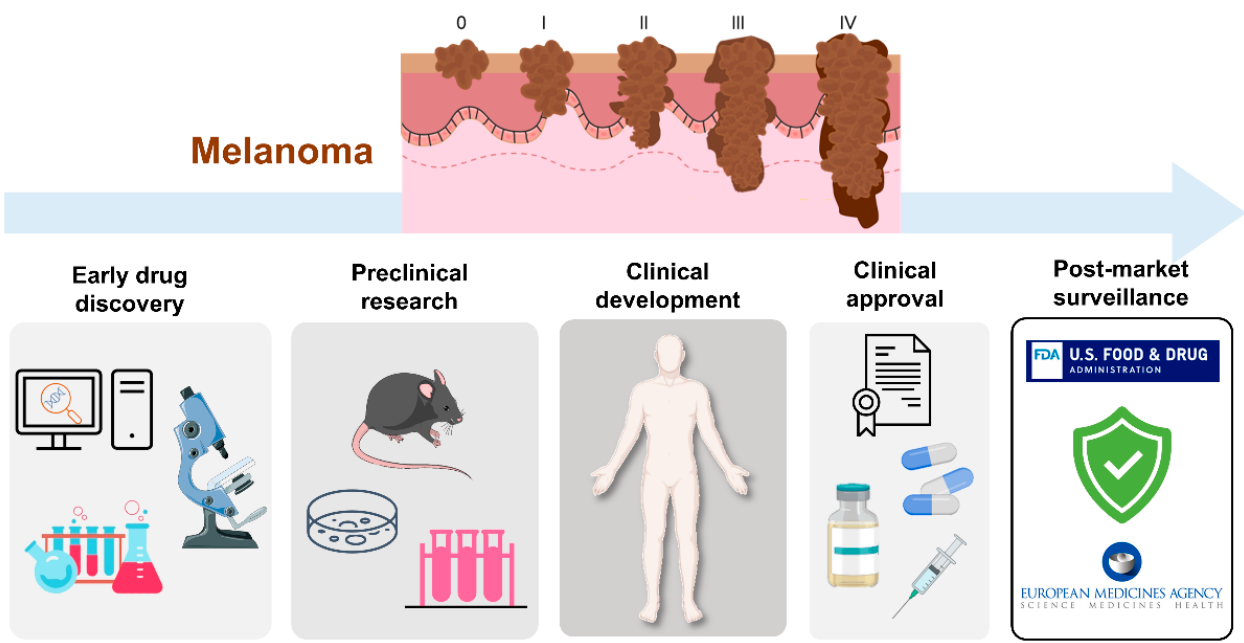
Figure 7. Schematic representation of melanoma drug development pipeline.